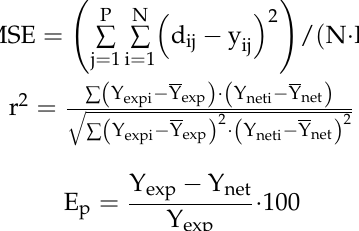
Table 2. Different types of ANN tested and their performance in the training stage.